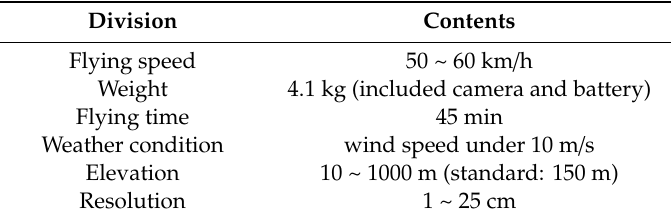
Table 1. Specifications of the Firefly UAV.